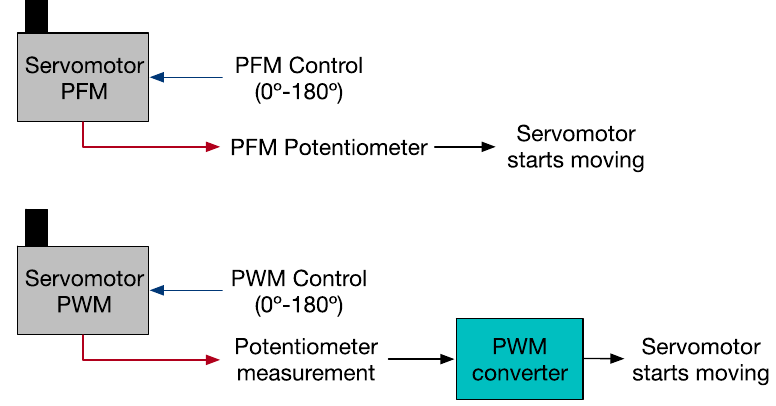
Figure 13. Block diagram about response speed study of servomotors. Both servomotors spin from 0° to 180°. Control and feedback signals are acquired for the following comparison and study.